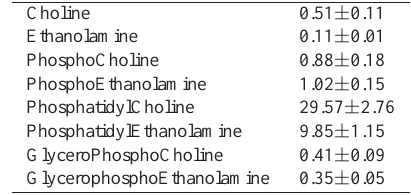
Table 1: Initial concentrations of rat liver metabolites Choline